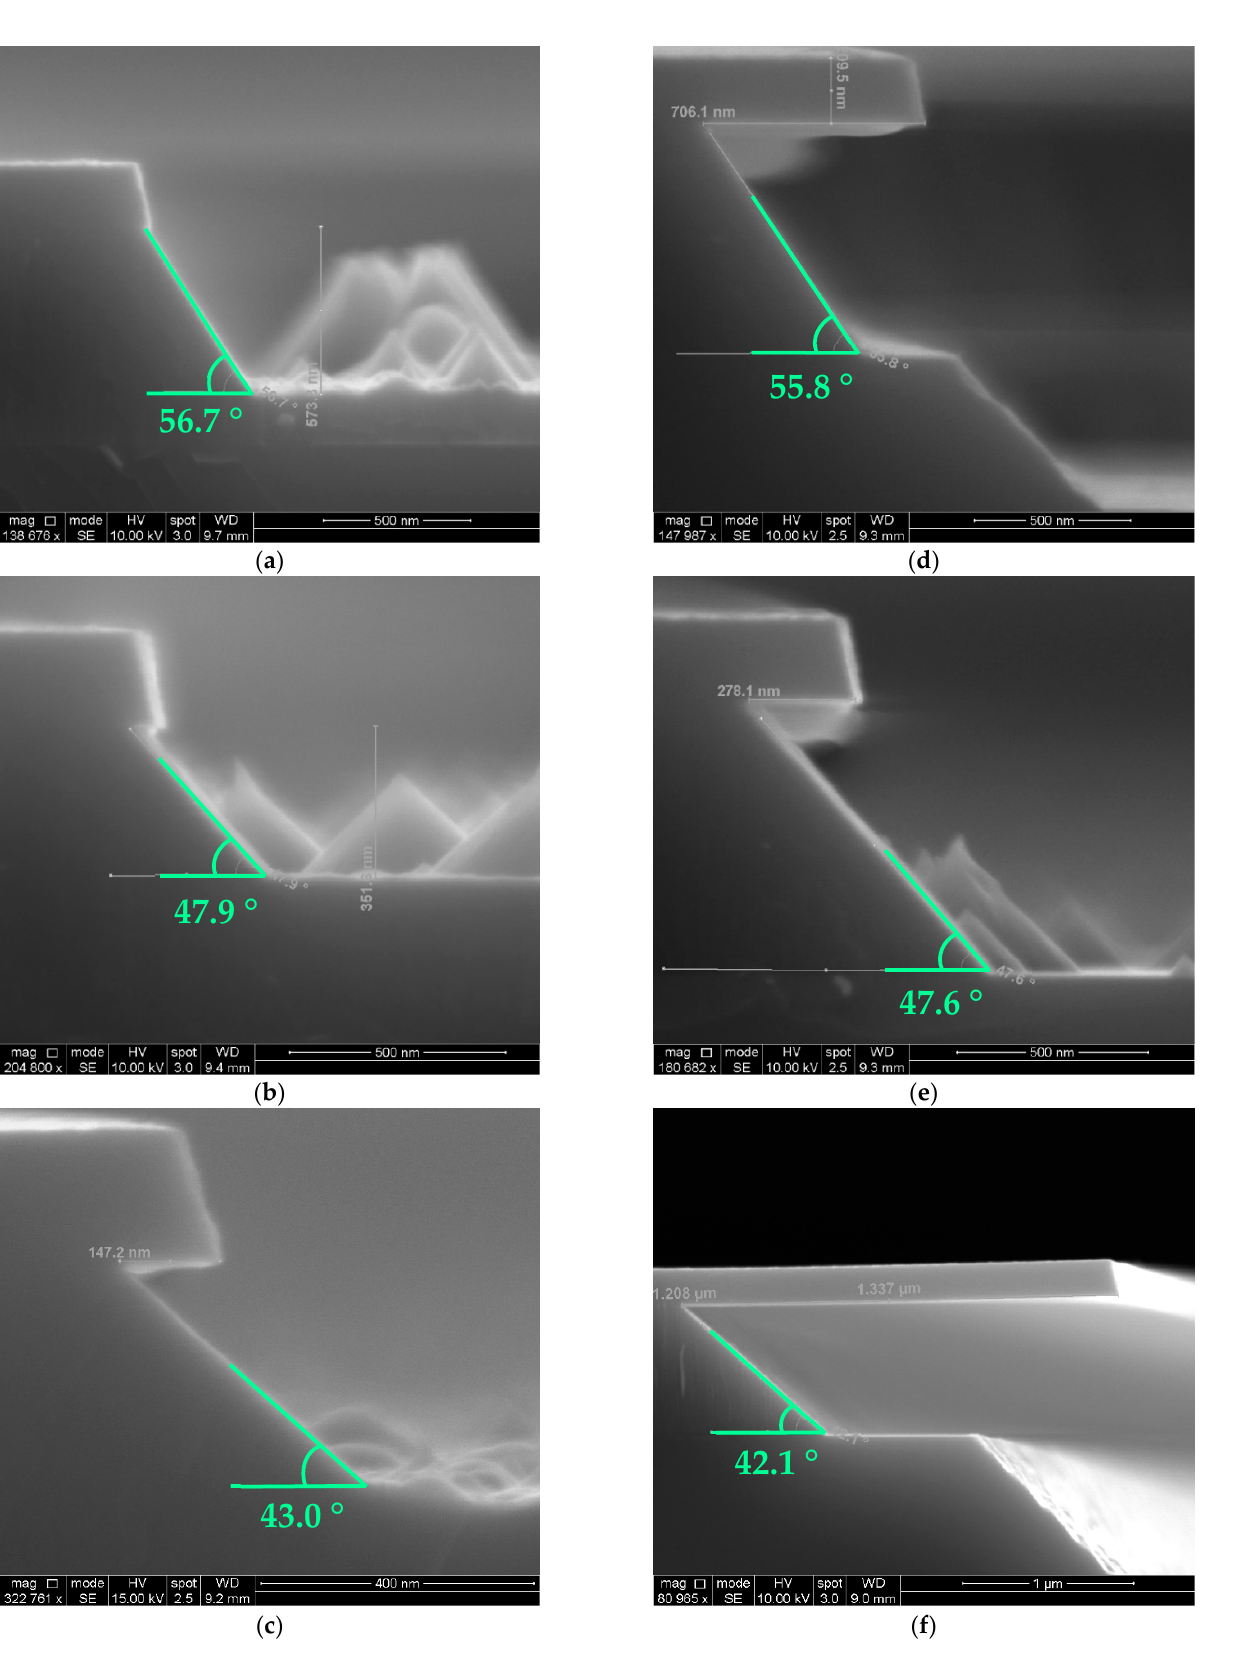
Figure 7. ( a ) Al 0.90 Sc 0.10 N etched for 20 s; ( b ) Al 0.75 Sc 0.25 N etched for 60 s; ( c ) Al 0.64 Sc 0.36 N etched for 80 s; ( d ) Al 0.90 Sc 0.10 N etched for 10 min; ( e ) Al 0.75 Sc 0.25 N etched for 5 min; ( f ) Al 0.64 Sc 0.36 N